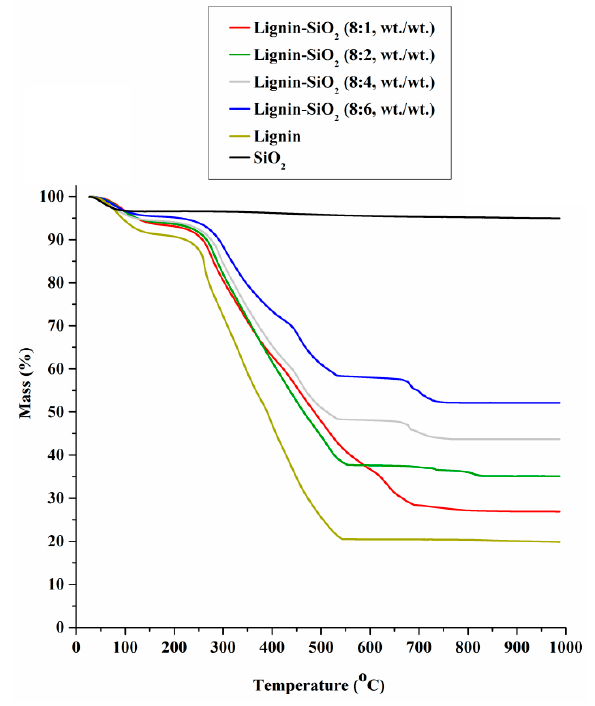
Figure 3. Thermogravimetric curves for lignin, silica and lignin–silica hybrid fillers. Table 3. Compounds detected in TG-MS analysis for lignin–silica hybrid fillers and pure lignin. Lignin–SiO 2 Lignin–SiO 2 Lignin–SiO 2 Lignin–SiO 2 Compound (8:1, wt./wt.) (8:2, wt./wt.) (8:4, wt./wt.)